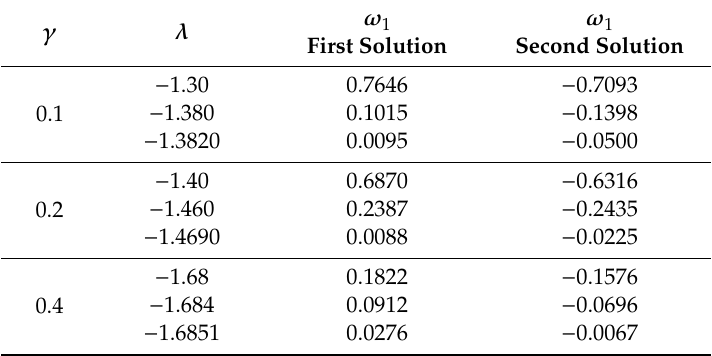
Table 4. Smallest eigenvalues ω 1 for some values of λ when γ =